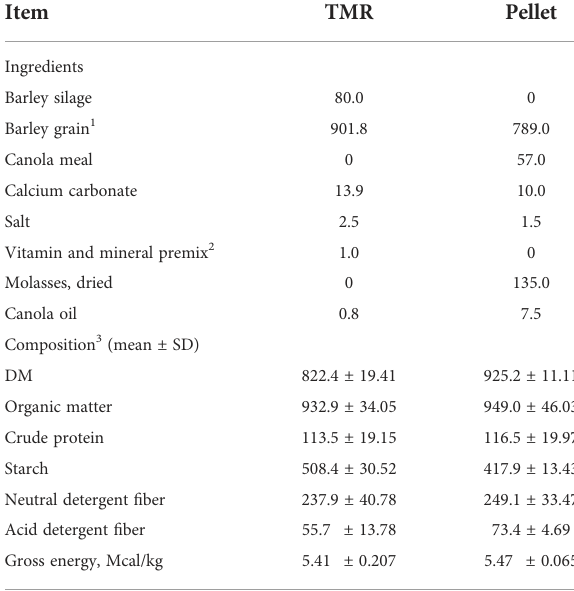
TABLE 1 Composition of the fi nishing total mixed ration (TMR) and pellet delivered by the GreenFeed system (g/kg of